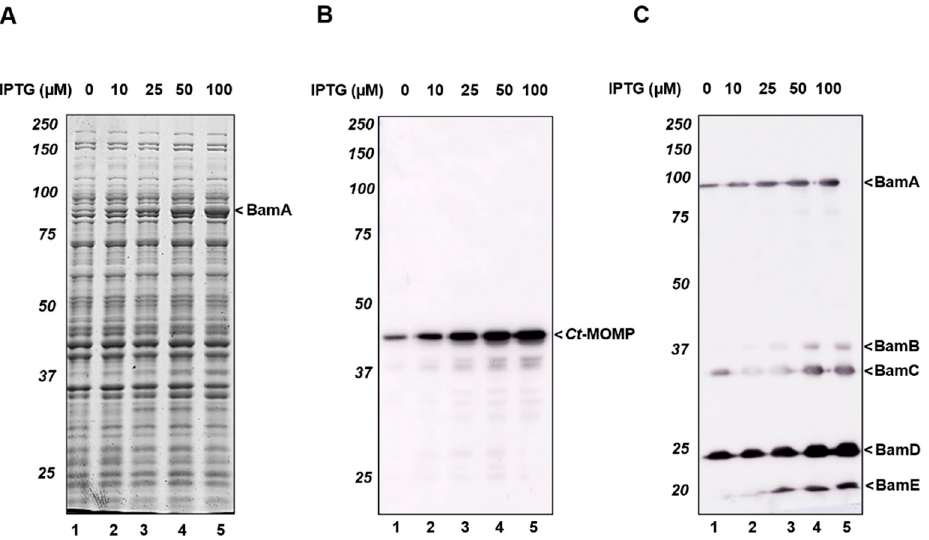
Figure 1. Co-expression of the Bam complex improved the production of Ct -MOMP in E. coli . ( A ) E. coli BL21(DE3) cells co-expressing Ct -MOMP and E. coli Bam were analyzed by SDS-PAGE and Coomassie staining. Cells were induced for expression of the Bam complex with various concentrations of IPTG (0–100 μ M) for 1 h and subsequently induced for production of Ct -MOMP with 8 mM L-rhamnose for 2 h. ( B , C ) Immunoblotting analysis of the whole-cell lysates using antisera against Ct -MOMP ( B ) or the Bam complex ( C ). Molecular weight (kDa) markers were indicated at the left side of the panels, the identified protein bands were indicated at the right side of the panels.